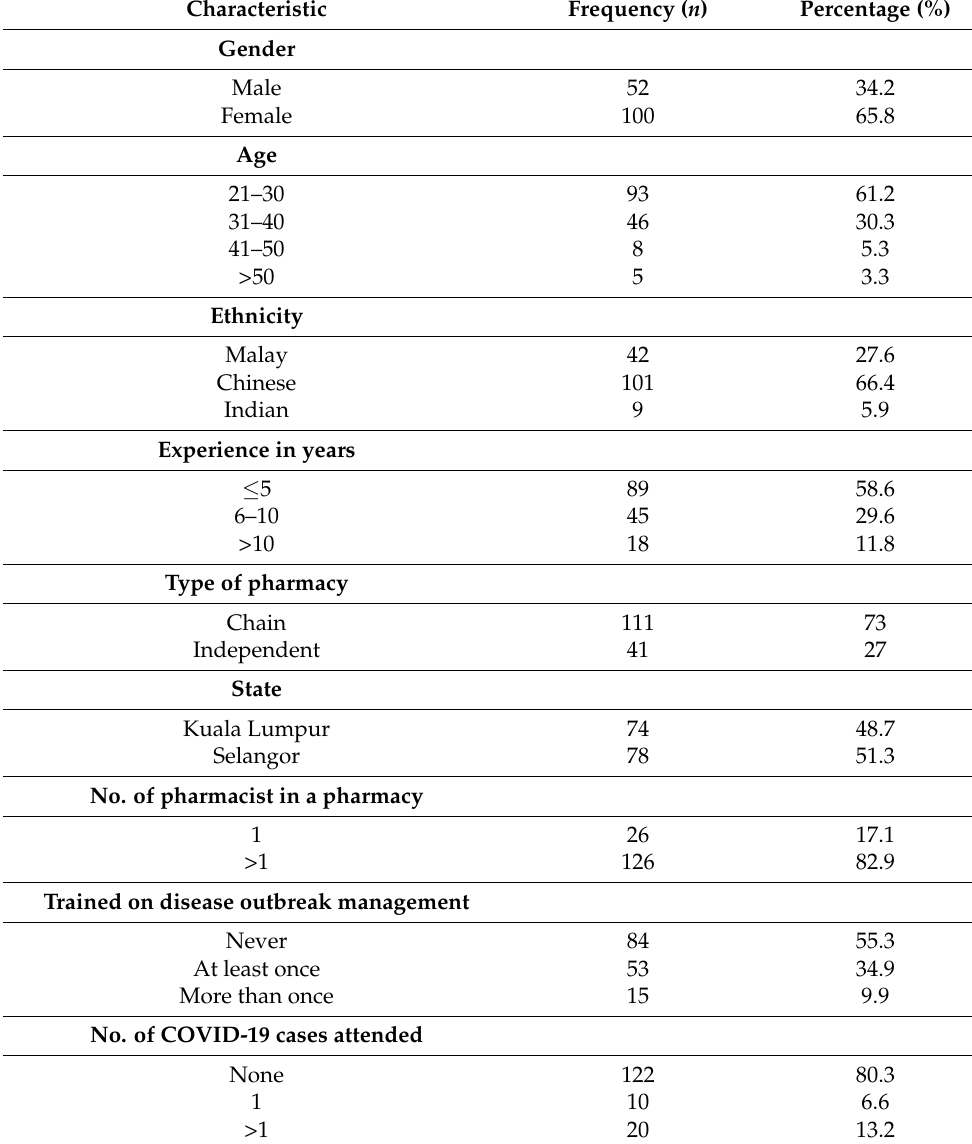
Table 1. Socio-demographic characteristics of participants ( n =